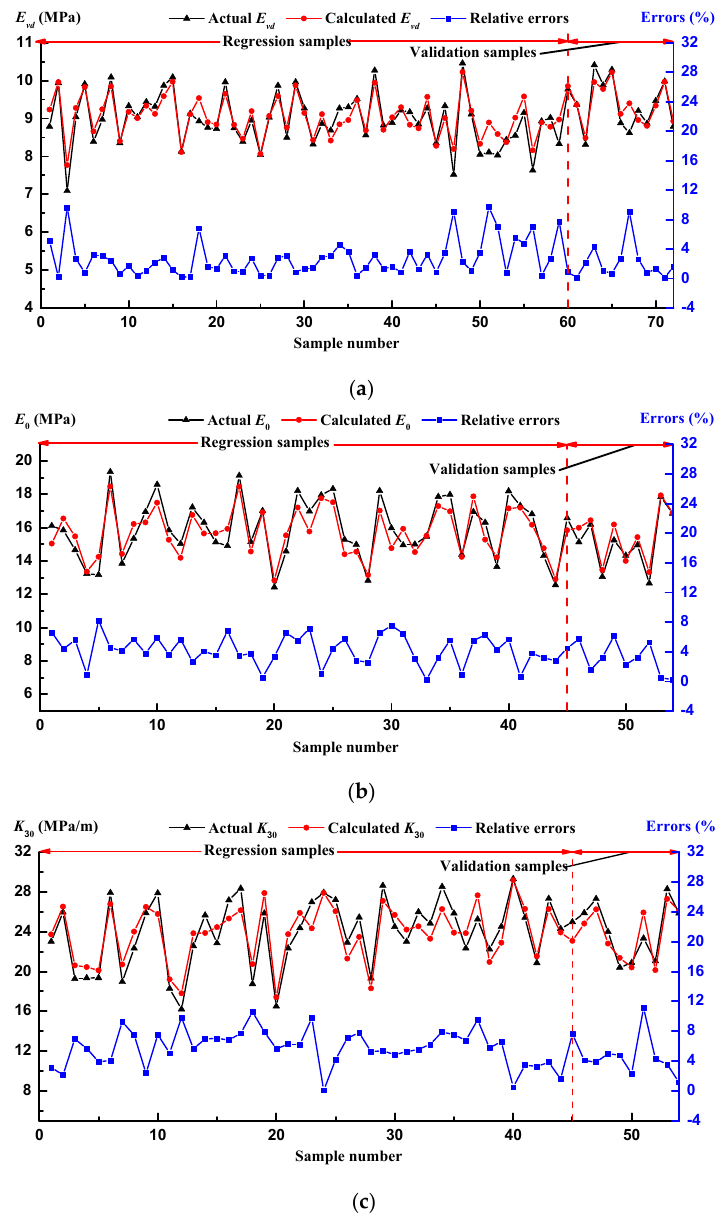
Figure 6. Cross validation of physical indices: ( a ) 𝐸 (cid:3049)(cid:3031) ; ( b ) 𝐸 (cid:2868) ; ( c ) 𝐾 (cid:2871)(cid:2868) .